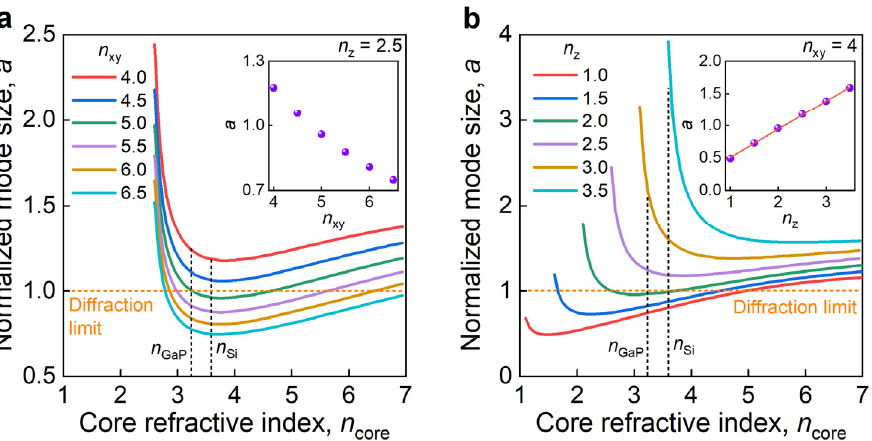
Figure 3. Parameter dependence of waveguide mode size. Optimal mode size for various ( a ) in-plane refractive indices at a fixed out-of-plane component ( n z = 2.5) and ( b ) out-of-plane refractive index at a fixed in-plane component ( n xy = 4.0). The insets show the minimum of normalized mode size dependence on in-plane and out-of-plane refractive indices.